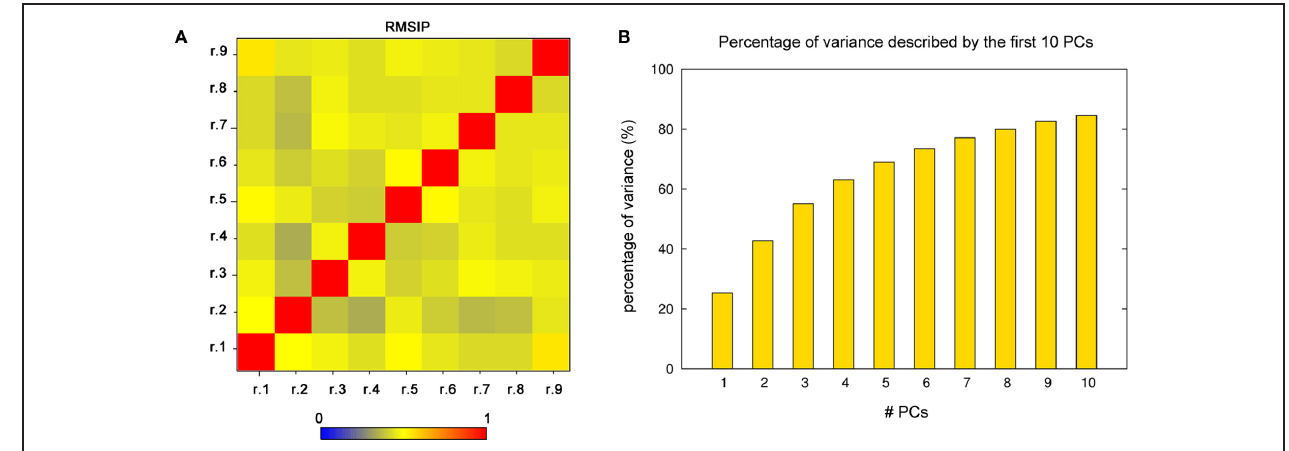
FIGURE 4 | PCA analysis. (A) RMSIP matrix calculated for each pairwise comparison of the single replicates, using the conformational space described by the first 10PCs. The RMSIP values are highlighted by a color